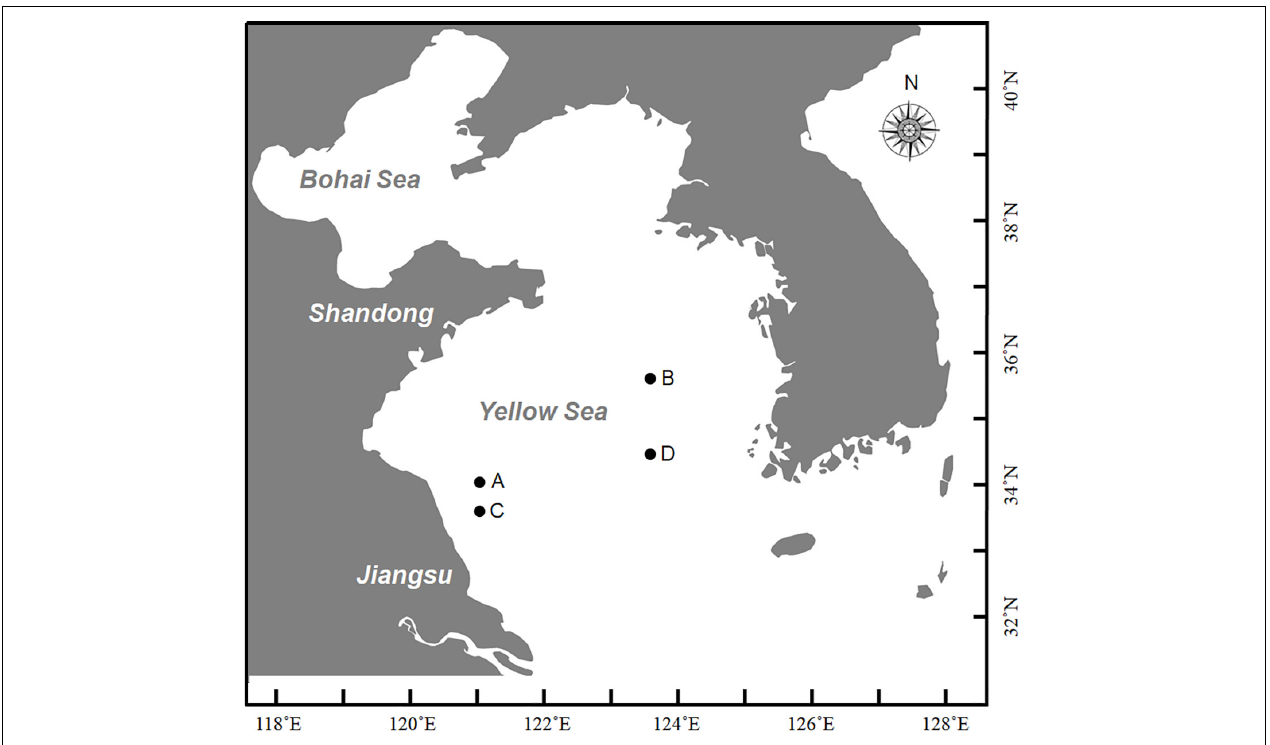
FIGURE 1 | Sites for sampling in this study during Ke Xue III cruise. A and C represented nearshore sites with lower transparency where floating seaweeds were in brown color; B and D represented offshore sites with higher transparency where floating seaweeds were in yellow color.